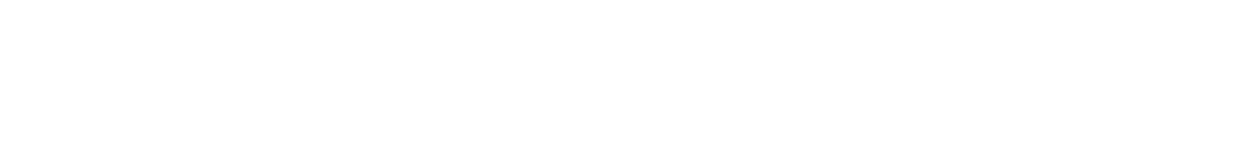
TABLE 1 | The percentage increase of the elliptic fl ow of proton due to the electromagnetic force evolution created in relativistic Pb + Pb collision with collision energy of (cid:4) √ (cid:1) 2.76 ATeVatcentrality rangingfrom20to30%(impactparametersintherange6.24 fm < b < 9.05 fm).Thechangeinelliptic fl ow( Δ V s V 2 theory and V 2 with